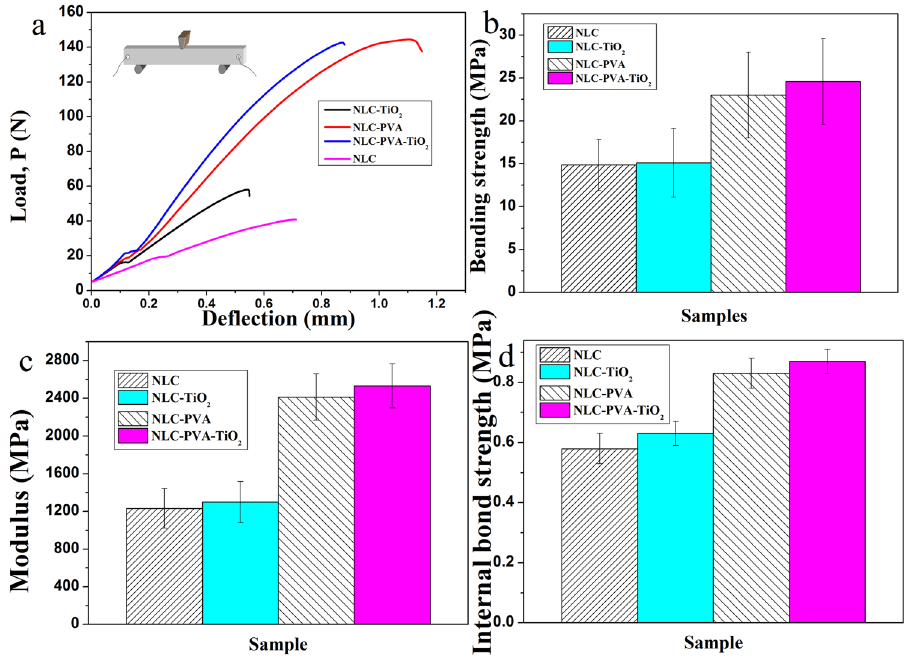
Figure 5. ( a ) The three-point bending tests force-displacement curves, ( b ) binding strength, ( c ) elasticity modulus and ( d ) internal bond strength of pure NLC, NLC/TiO 2 composite, NLC/PVA composite and NLC/ PVA/TiO 2